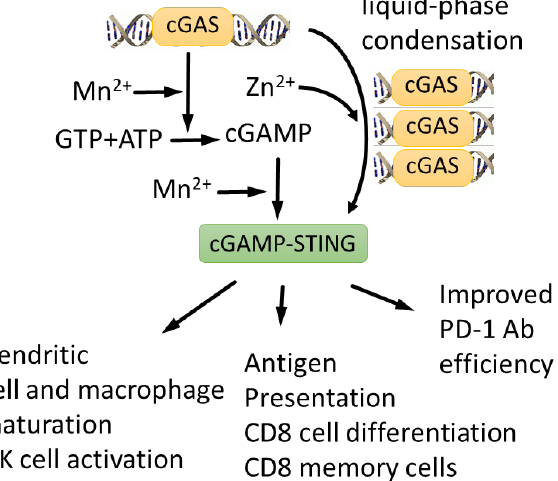
Figure 5. cGAS-STING signaling pathway is activated by both Mn 2+ and Zn 2+ . Mn 2+ is required for efficient DNA sensing, cGAMP synthesis and cGAMP-STING complex formation [63], whereas Zn 2+ is required for cGAMP folding and liquid-phase separation of cGAMP-DNA complexes [172–174]. Mn 2+ potentiates cGAS-STING anti-tumor response, stimulating dendritic cell and macrophage maturation, NK cell activation, antigen presentation and CD8 cell differentiation [44]. As a result, Mn 2+ enhances efficiency of therapeutic antibodies [170].